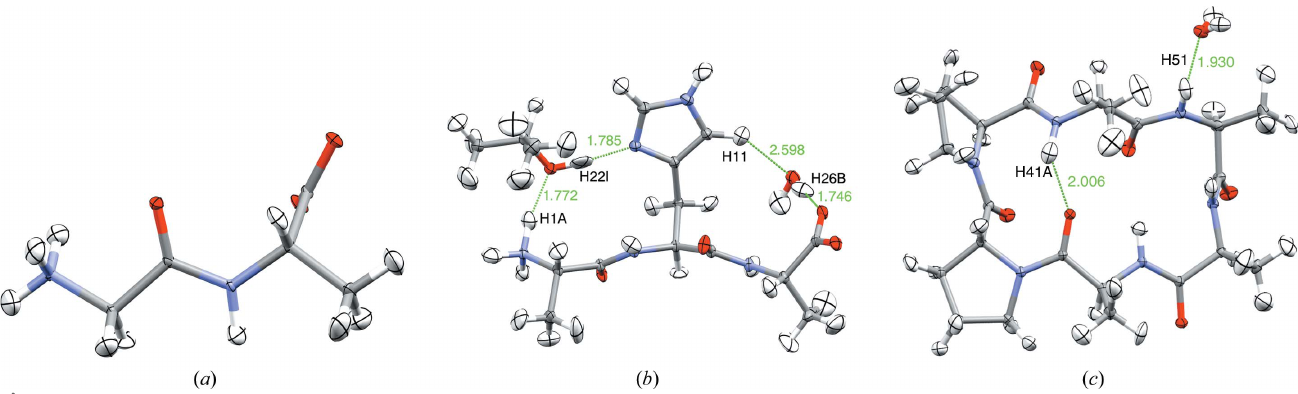
Figure 2 Crystal structures (100 K) of the three peptide model systems with 50% ADP probability ellipsoids. Hydrogen bonds are shown in green. ( a ) Gly-Ala (GA), ( b ) Ala-His-Ala (AHA), ( c ) cyclo -(Ala) 4 -( d , l -Pro) 2 (A 4 P 2